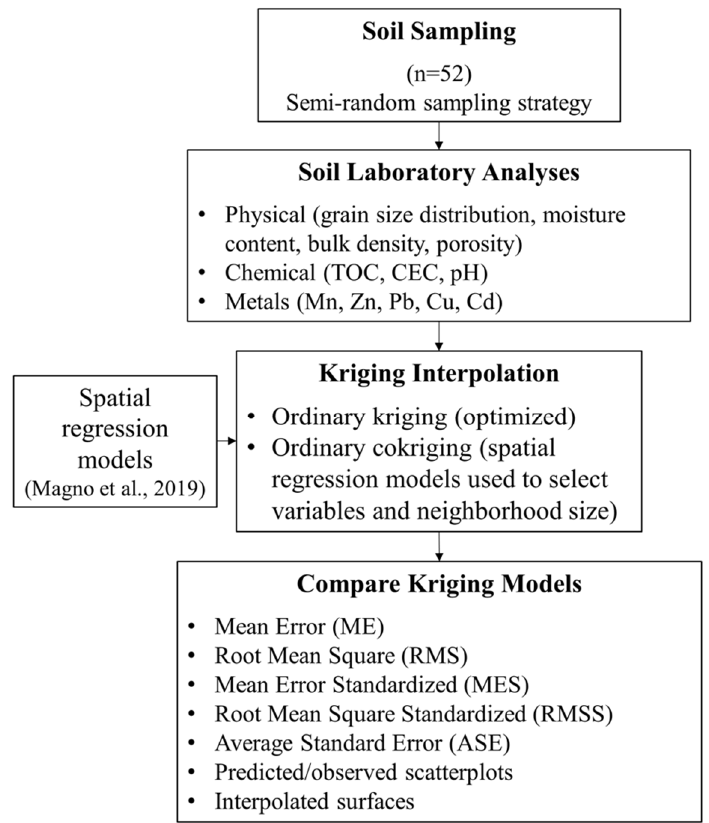
Figure 2. Description of